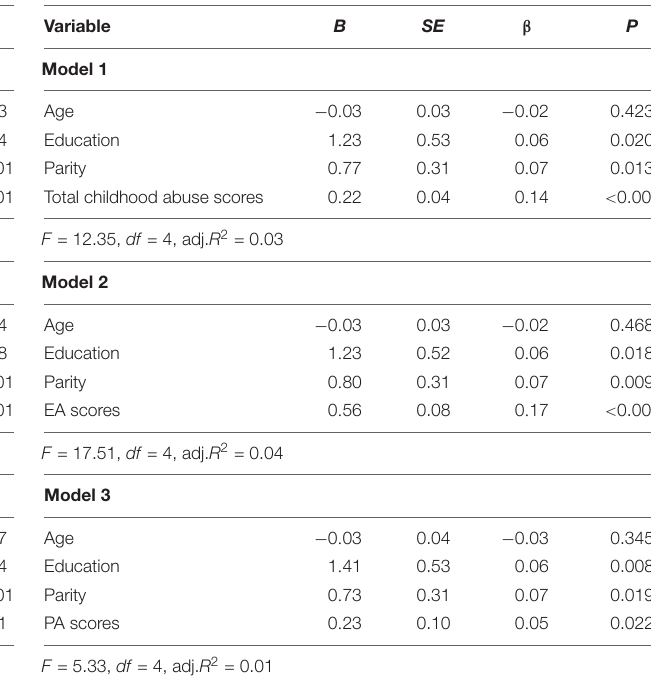
TABLE 2 | The association between childhood abuse and prospective memory. TABLE 3 | The association between childhood abuse and retrospective